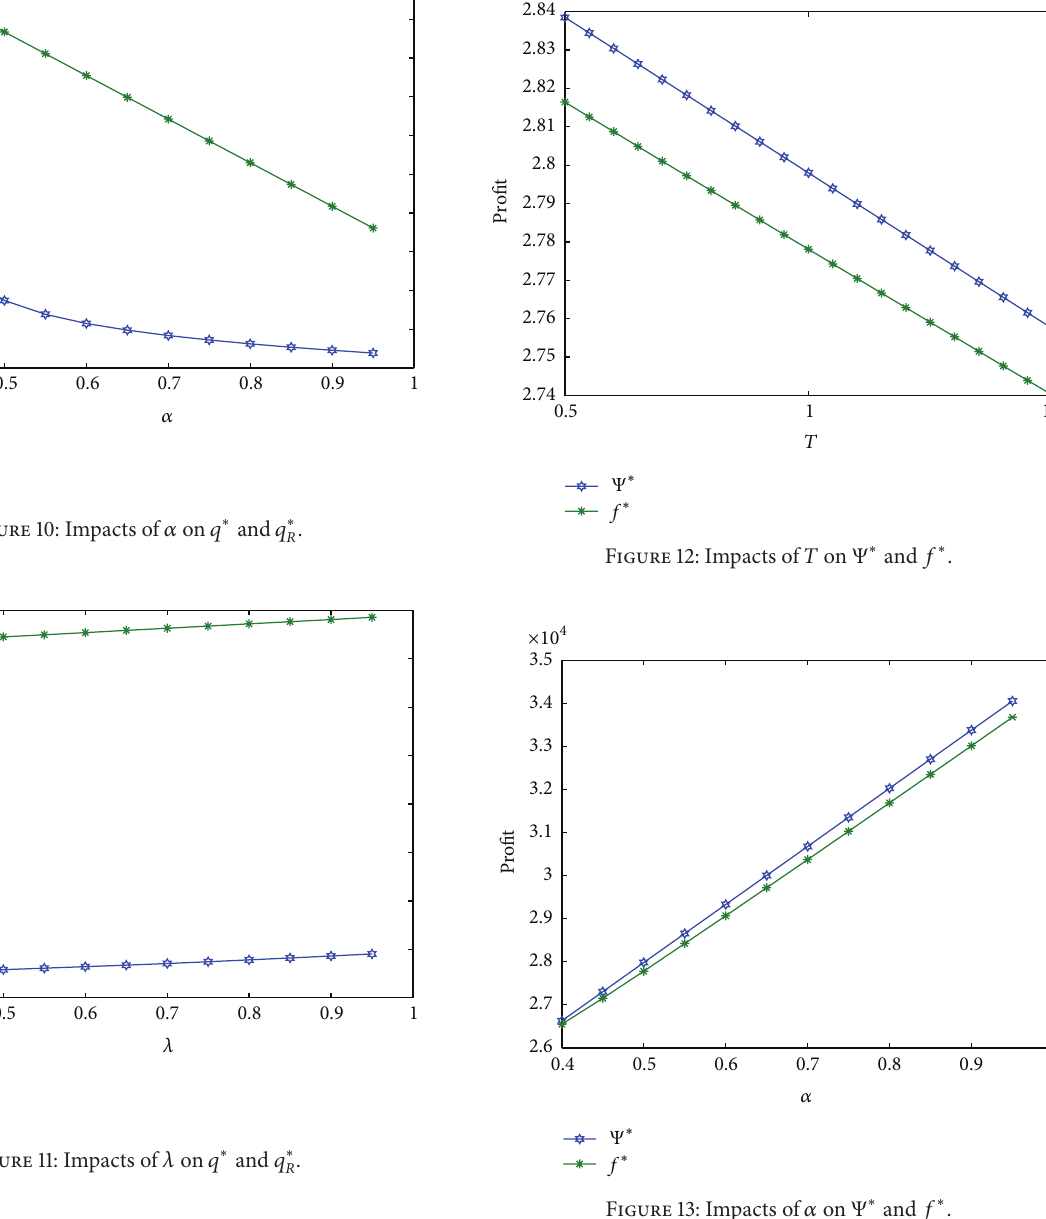
Figure 13: Impacts of 𝛼 on Ψ ∗ and 𝑓 ∗